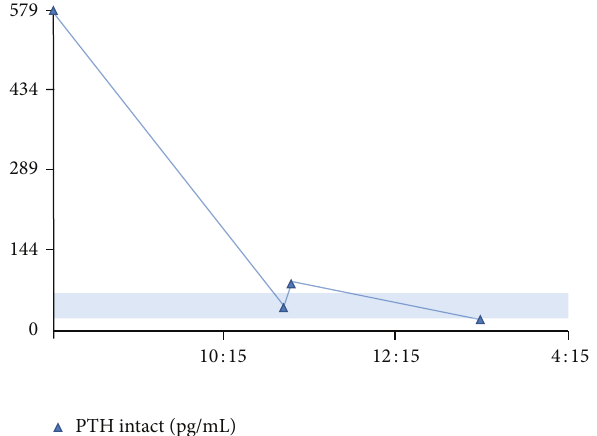
Figure 1: Intraoperative monitoring of PTH levels. Graph depicts marked decrease in parathyroid hormone levels following thy- roidectomy. PTH hormone dropped initially from 579 to 40 pg/mL, then 83 pg/mL, and finally to 16pg/mL. (PTH level is on y -axis, time is on x -axis, and shaded box represents PTH reference range from 15 to 65